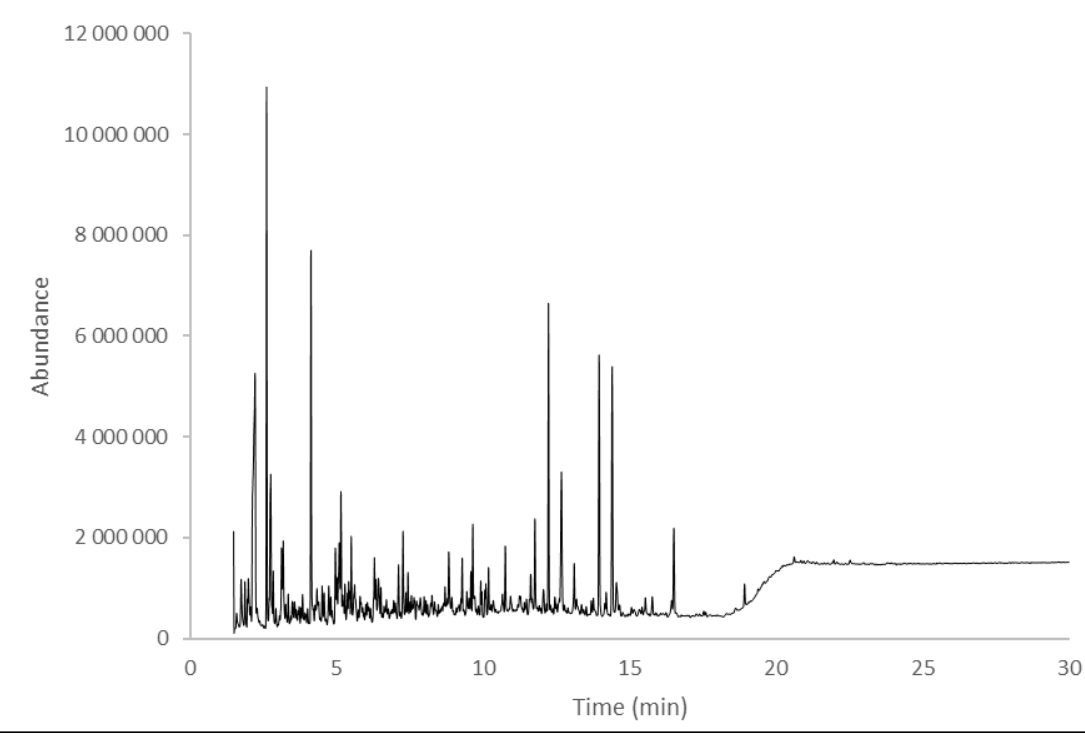
Figure 9. Py-GC-MS chromatogram of the S.1 mortar sample’s binding